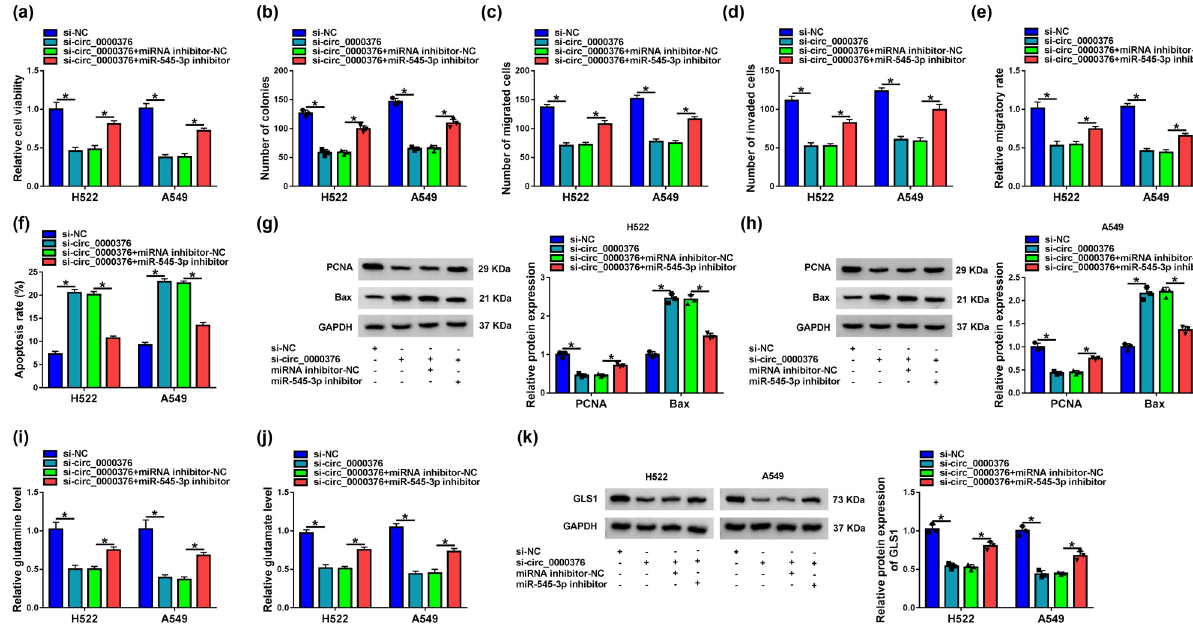
Figure 4: circ_0000376 knockdown repressed NSCLC cell tumor properties by binding to miR - 545 - 3p. ( a – k ) Both H522 and A549 cells were transfected with si - NC, si - circ_0000376, si - circ_0000376 + miRNA inhibitor - NC, and si - circ_0000376 + miR - 545 - 3p inhibitor, respectively. ( a and b ) Cell viability and colony - forming ability were detected by CCK - 8 assay and colony formation assay, respectively. ( c and e ) Transwell migration and wound - healing assays were performed to assess the migratory ability of H522 and A549 cells. ( d ) Transwell invasion assay was conducted to determine the invasive ability of H522 and A549 cells. ( f ) Cell apoptosis was detected by fl ow cytometry analysis. ( g and h ) Western blot analysis was performed to detect the protein expression of PCNA and Bax. ( i and j ) Levels of glutamine and glutamate were determined by glutamine determination and glutamate detection assays, respectively. ( k ) GLS1 protein expression was detected by western blot analysis. * P <